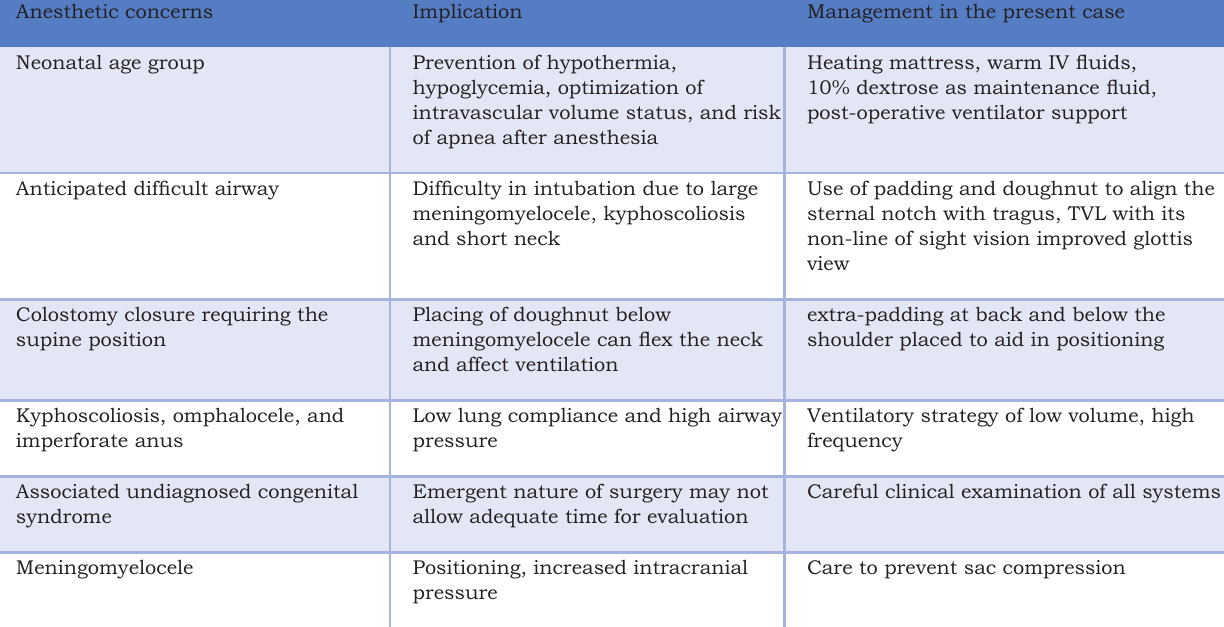
Table 1: Anesthetic concerns, their implication, and management in a patient with OEIS complex Anesthetic